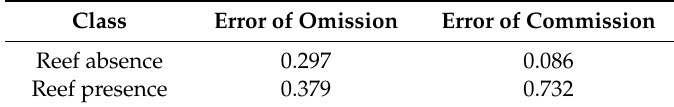
Table 5. Class-specific errors of omission and commission for the BTM method.